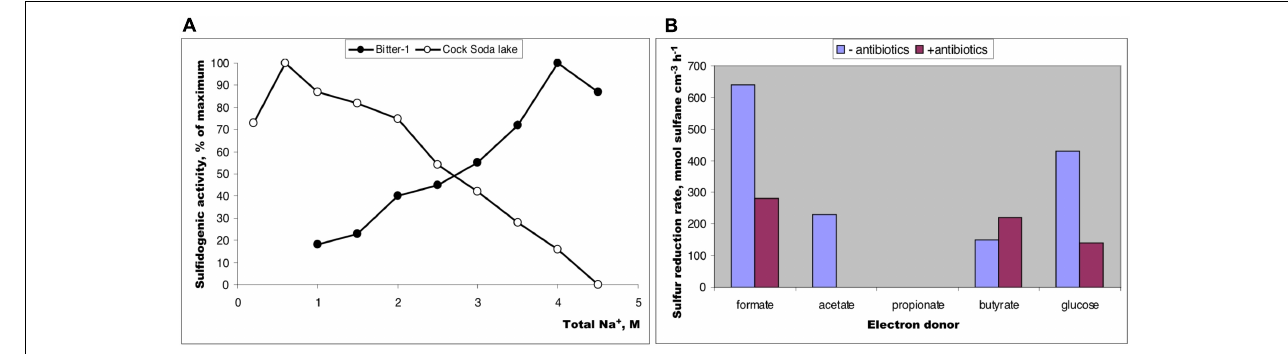
FIGURE 1 | Sulfur-reducing activity in anaerobic sediment slurry mix (1:1 with brines) from soda lakes in Kulunda Steppe (2011) incubated at 25 ◦ for 3–7 days. (A) Influence on salinity (as sodium carbonates) on potential sulfur reduction with formate as e-donor in sediments from moderately saline Cock Soda Lake and hypersaline Bitter-1 lake; (B) influence of antibiotics (streptomycin + kanamycin + vancomycin, 200 mg L − 1 each) on potential sulfur reduction is sediment slurry from a mix sample prepared from 3 hypersaline soda lakes: Tanatar-1, Bitter-1, and trona crystallizer (Kulunda Steppe, Altai, Russia). The lakes are located in a close proximity and had have a similar brine characteristics (see Supplementary Table S1 ). The maximum activity was estimated as an average value from two parallel replicated samples. Total sulfane is a sum of free HS − and the sulfane atoms of polysulfides. TABLE 1 | Natronarchaeal sulfur-reducing strains isolated from hypersaline alkaline lakes.